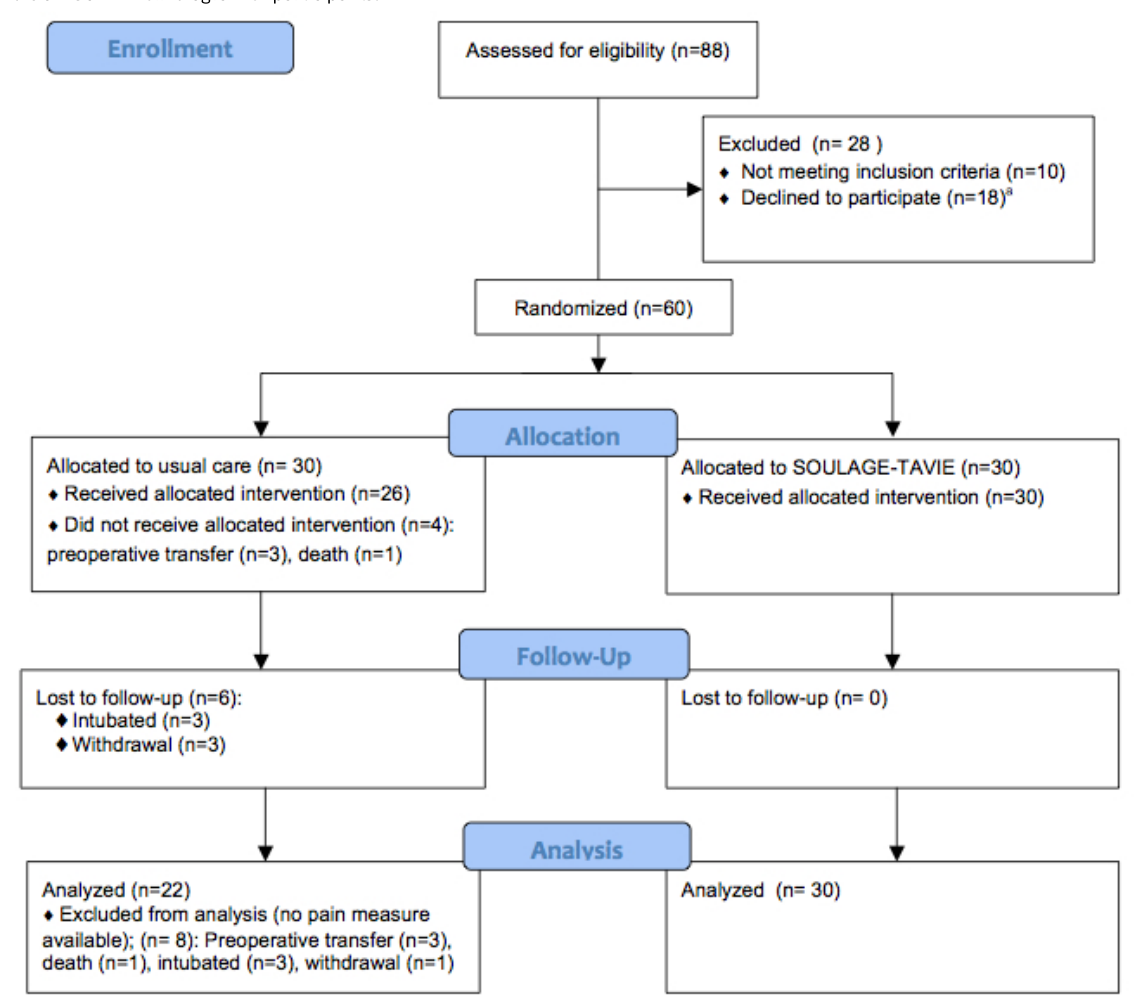
Figure 4. CONSORT flow diagram of